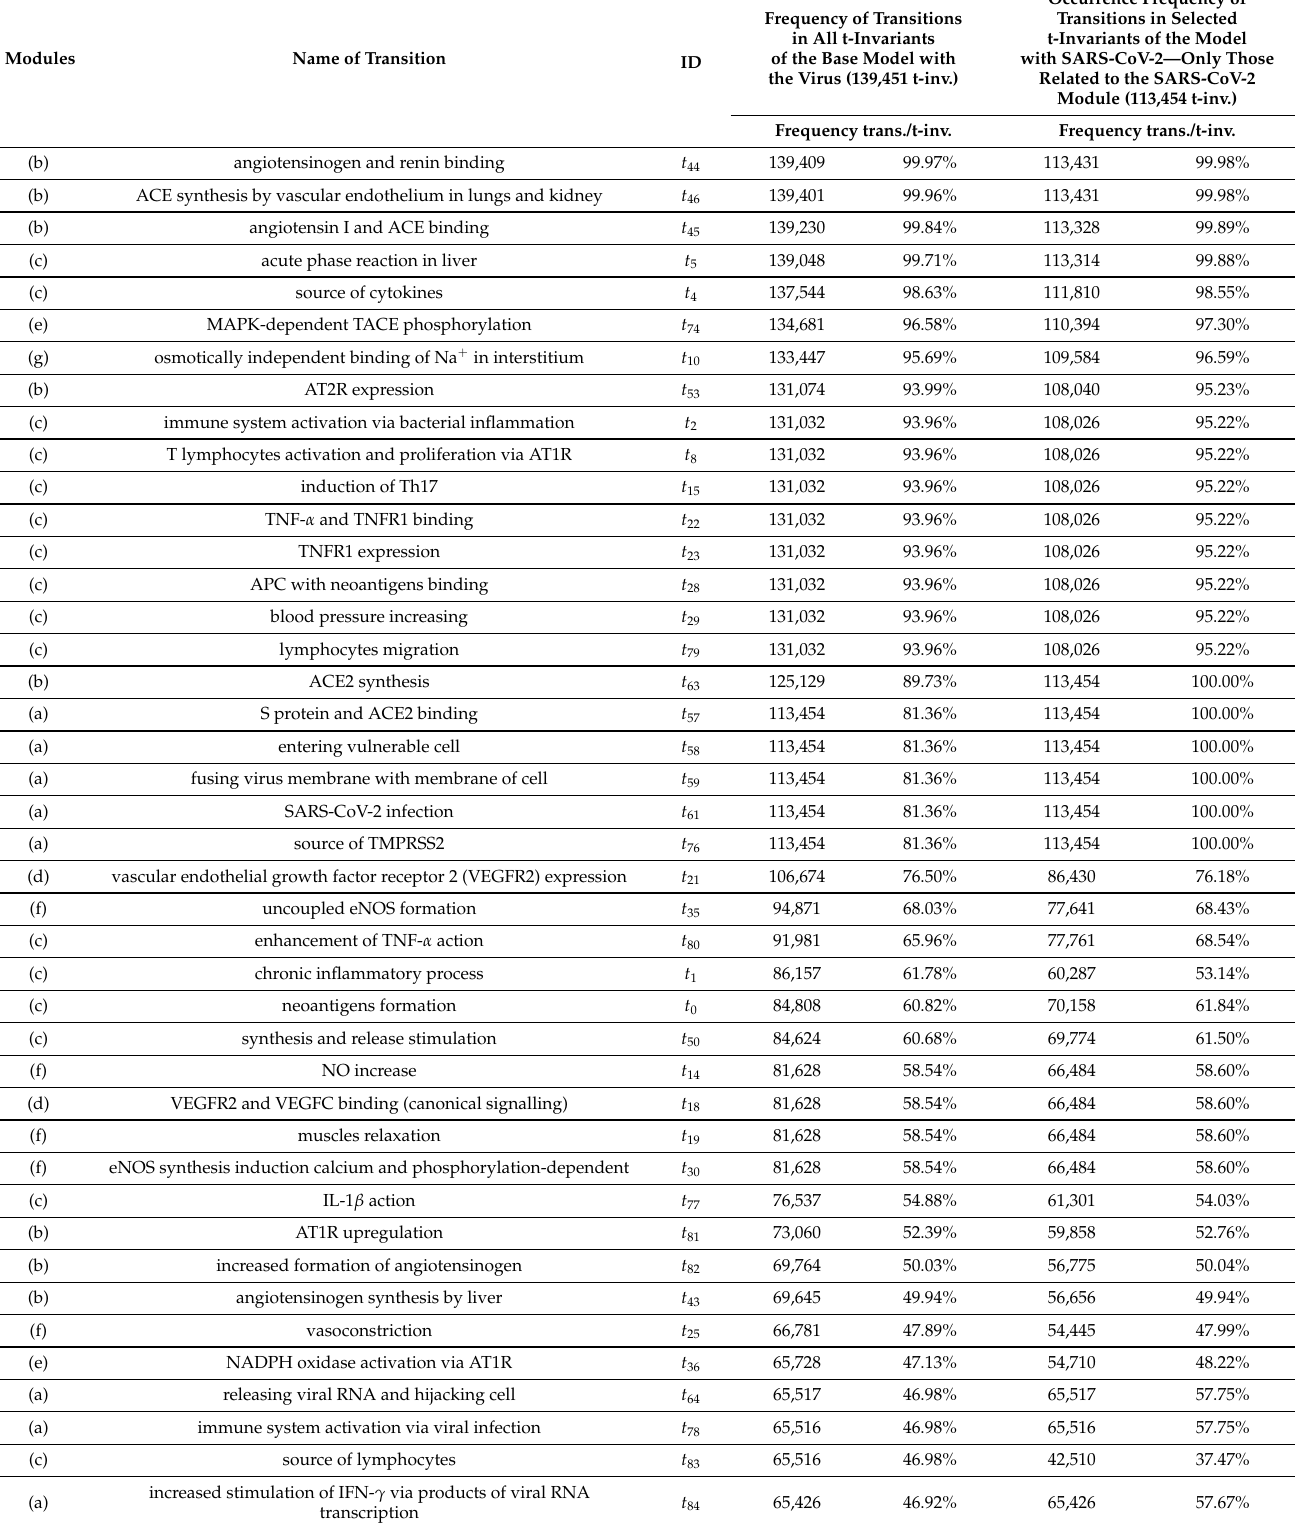
Table 3. The results of the significance analysis for selected elementary processes for t-invariants of the model with SARS- CoV-2, which are distinguished into two sets of t-invariants: all t-invariants and only those t-invariants which are related to the SARS-CoV-2 module